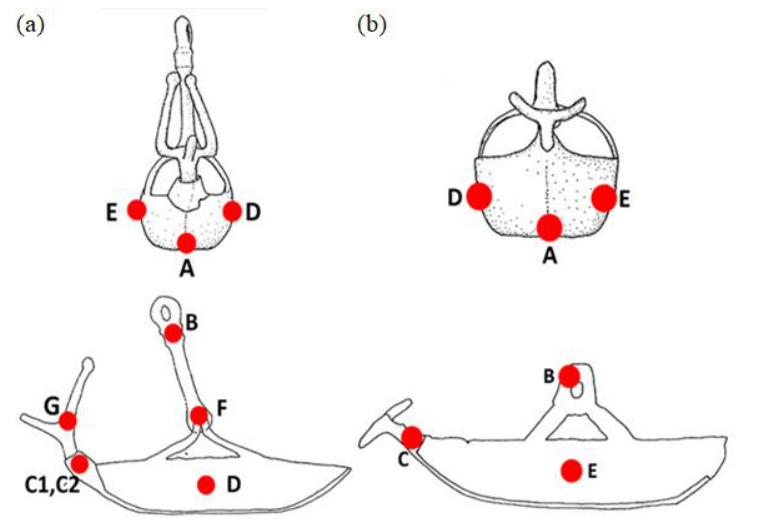
Figure 10. Drawing of the two samples and measured areas (red). ( a ) Model n.6779; ( b ) model n.6780.